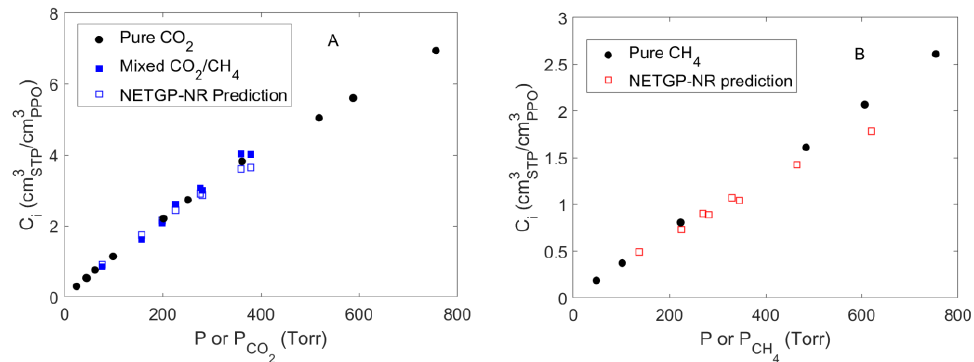
Figure 10. Pure and mixed gas sorption isotherms at 35 °C for CO 2 ( A ) and CH 4 ( B ) in amorphous PPO. Predictions are referred to mixture sorption and were obtained using NETGP-NR model.